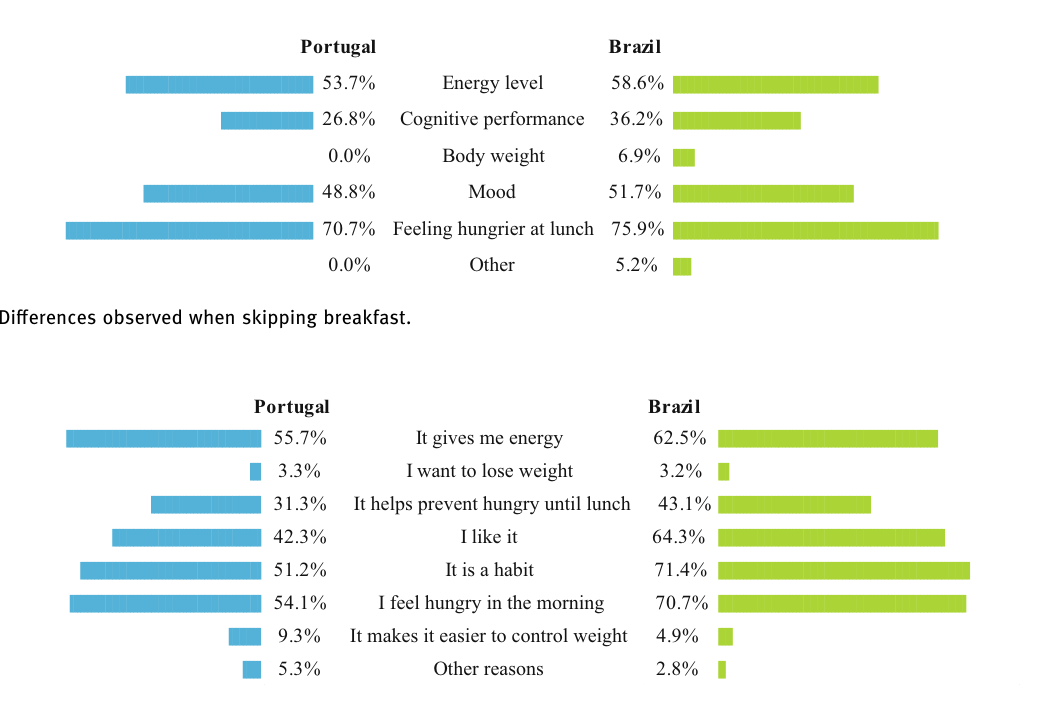
Figure 6: Reasons pointed out to always have breakfast.